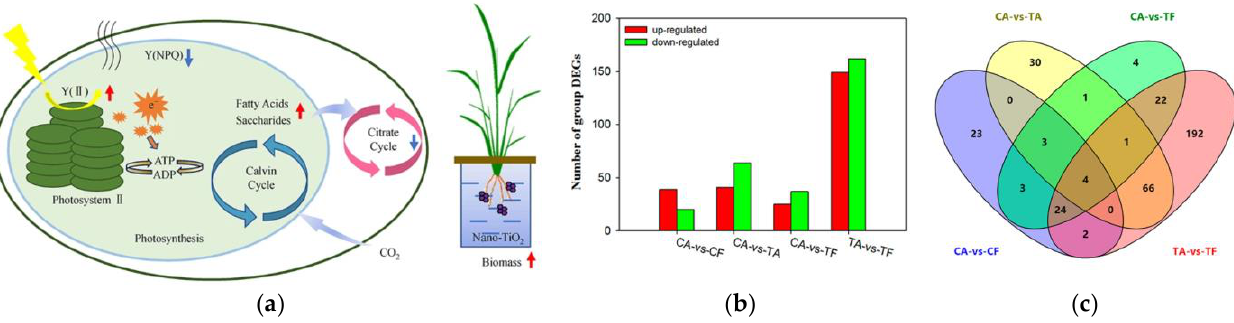
Figure 12. ( a ) Photosynthesis and related metabolic mechanisms of TiO 2 nanoparticles for rice growth. Reprinted with permission from Ref. [88]. 2020, Springer-Verlag; ( b ) number of differentially expressed genes (DEGs) between each group; ( c ) Venn diagram showing the number of significant DEGs in each group. CA, CF, TA, and TF indicate ambient CO 2 control, elevated CO 2 control, ambient CO 2 with nano-TiO 2 , and elevated CO 2 with nano-TiO 2 , respectively. Reprinted with permission from Ref. [97]. 2019, American Chemical Society.